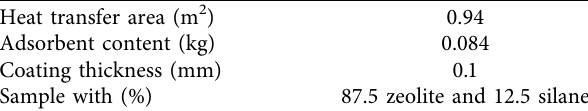
Table 2: Main features of the coated adsorbent bed.